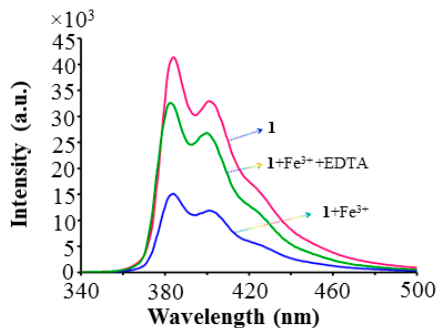
Figure 7. Fluorescence intensity changes of 1 upon the addition of Fe 3+ and the demetalation (removal of Fe 3+ ) by the addition of EDTA in ACN:H 2 O (1:1, v / v